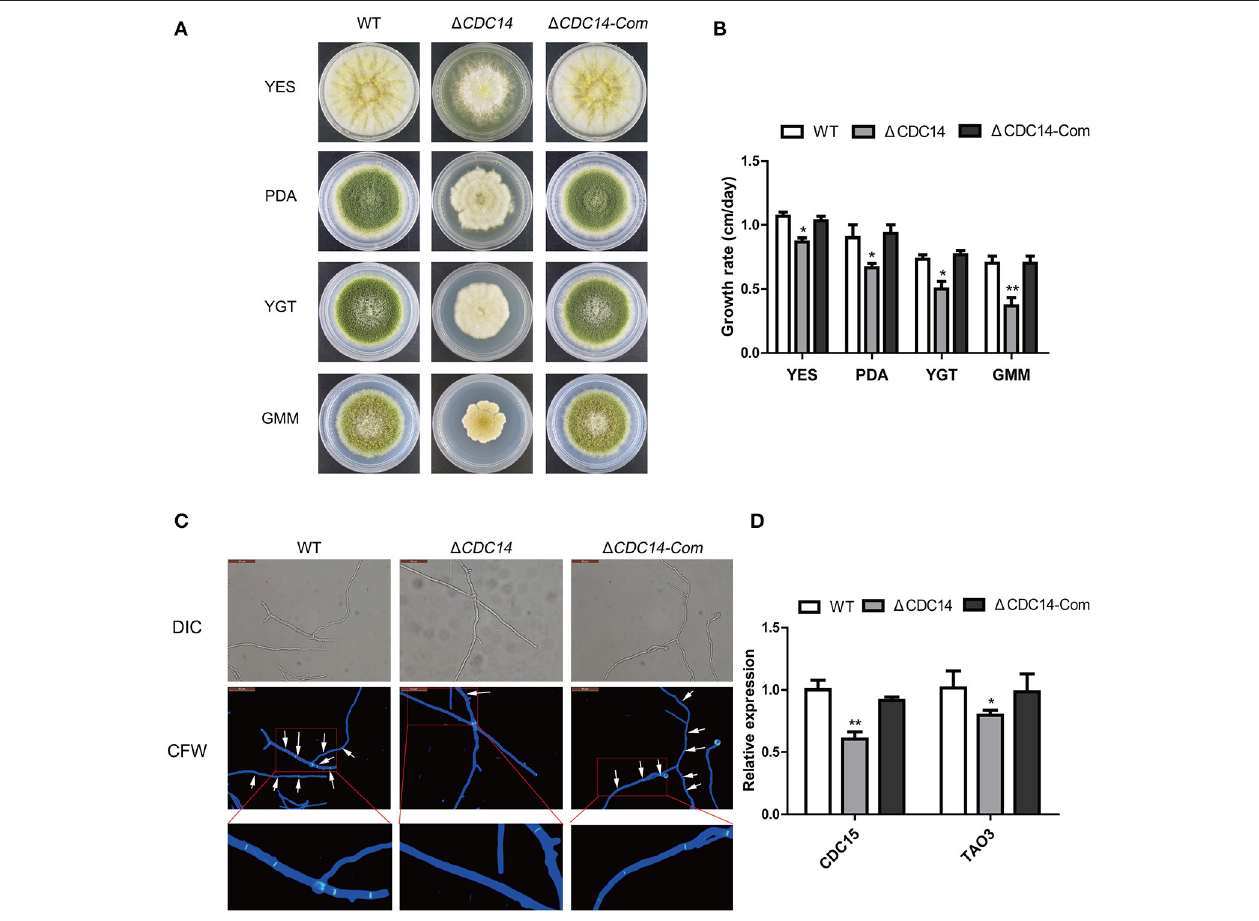
FIGURE 3 | Growth and septum formation defects of the 1 CDC14 mutant. (A) Colony morphology of WT, 1 CDC14 and 1 CDC14- Com strains, grown on YES at 37 ◦ C for 3 d, and PDA, YGT, GMM media for 7 d. (B) Growth rate of WT, 1 CDC14 and 1 CDC14- Com strains on different media. (C) Fluorescent images of hyphal cells stained with calcofluor white (CFW) revealed the defect of septum formation in 1 CDC14 mutant, bars = 50 µ m. (D) Relative transcript levels of septum formation related genes CDC15 and TAO3 were down-regulated, after cultured on PDA medium at 37 ◦ C for 48h. Actin was used as the endogenous gene, and calculated by 2 − 11 Ct method (* p ≤ 0.05, ** p ≤